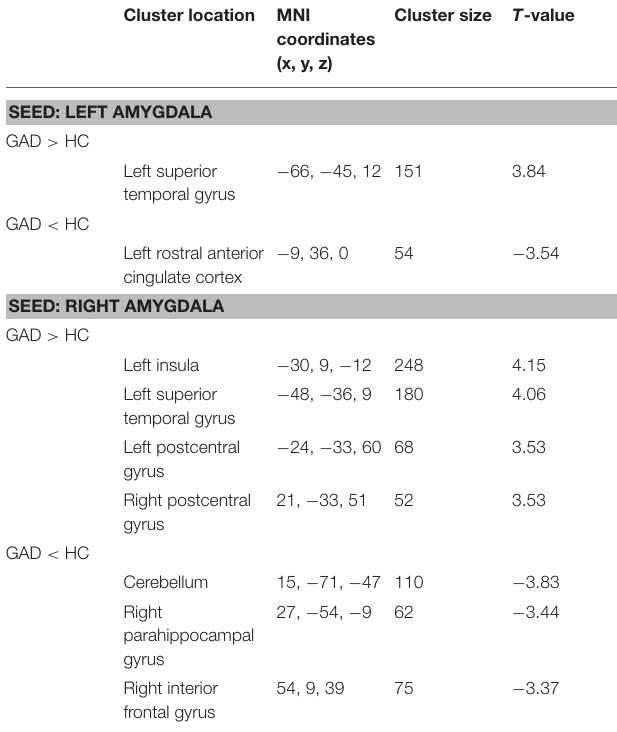
TABLE 2 | Group comparison of functional connectivity between the bilateral amygdala and whole